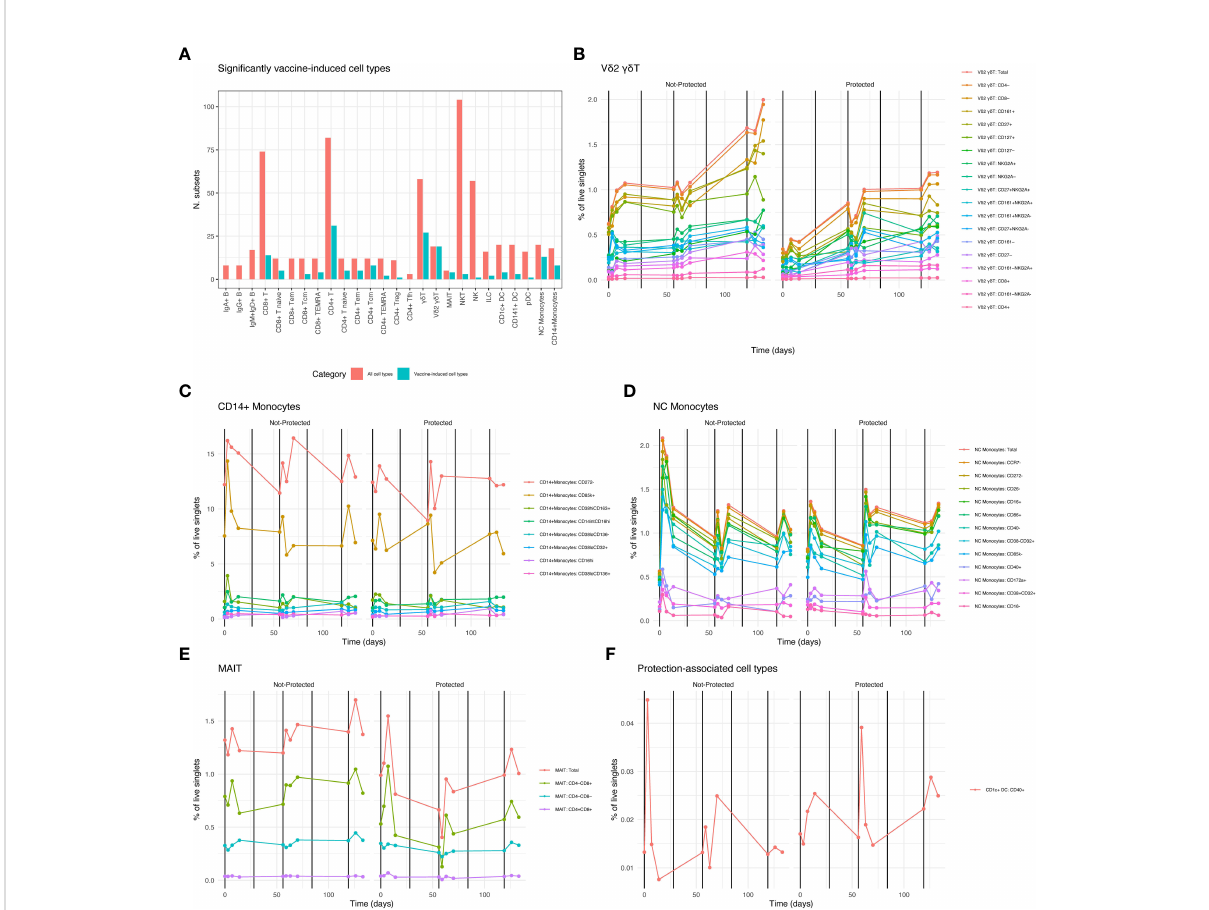
FIGURE 5 RAS Vaccine-induced and protection associated cell types. (A) Counts of signi fi cantly (FDR < 0.05) vaccine-induced cell types grouped by lineage and/or function. Red columns indicate total numbers of gated subsets in the corresponding group, adjacent teal columns show proportion of gated subsets that were vaccine-induced. B-E Averaged counts of vaccine-induced cell types showing vaccine induced cell types from speci fi c lineage/function groupings in A., over time. Vertical black lines indicate vaccination times. Legend shows color for each gated cell type subset, ordered from most abundant (top) to least abundant (bottom). (B) V d 2 gd T cells, (C) Classical CD14+ monocytes, (D) Non-classical (NC) monocytes, (E) MAIT cells. (F) Averaged counts of the protection-associated (FDR < 0.05) cell type: CD1c+ CD40+